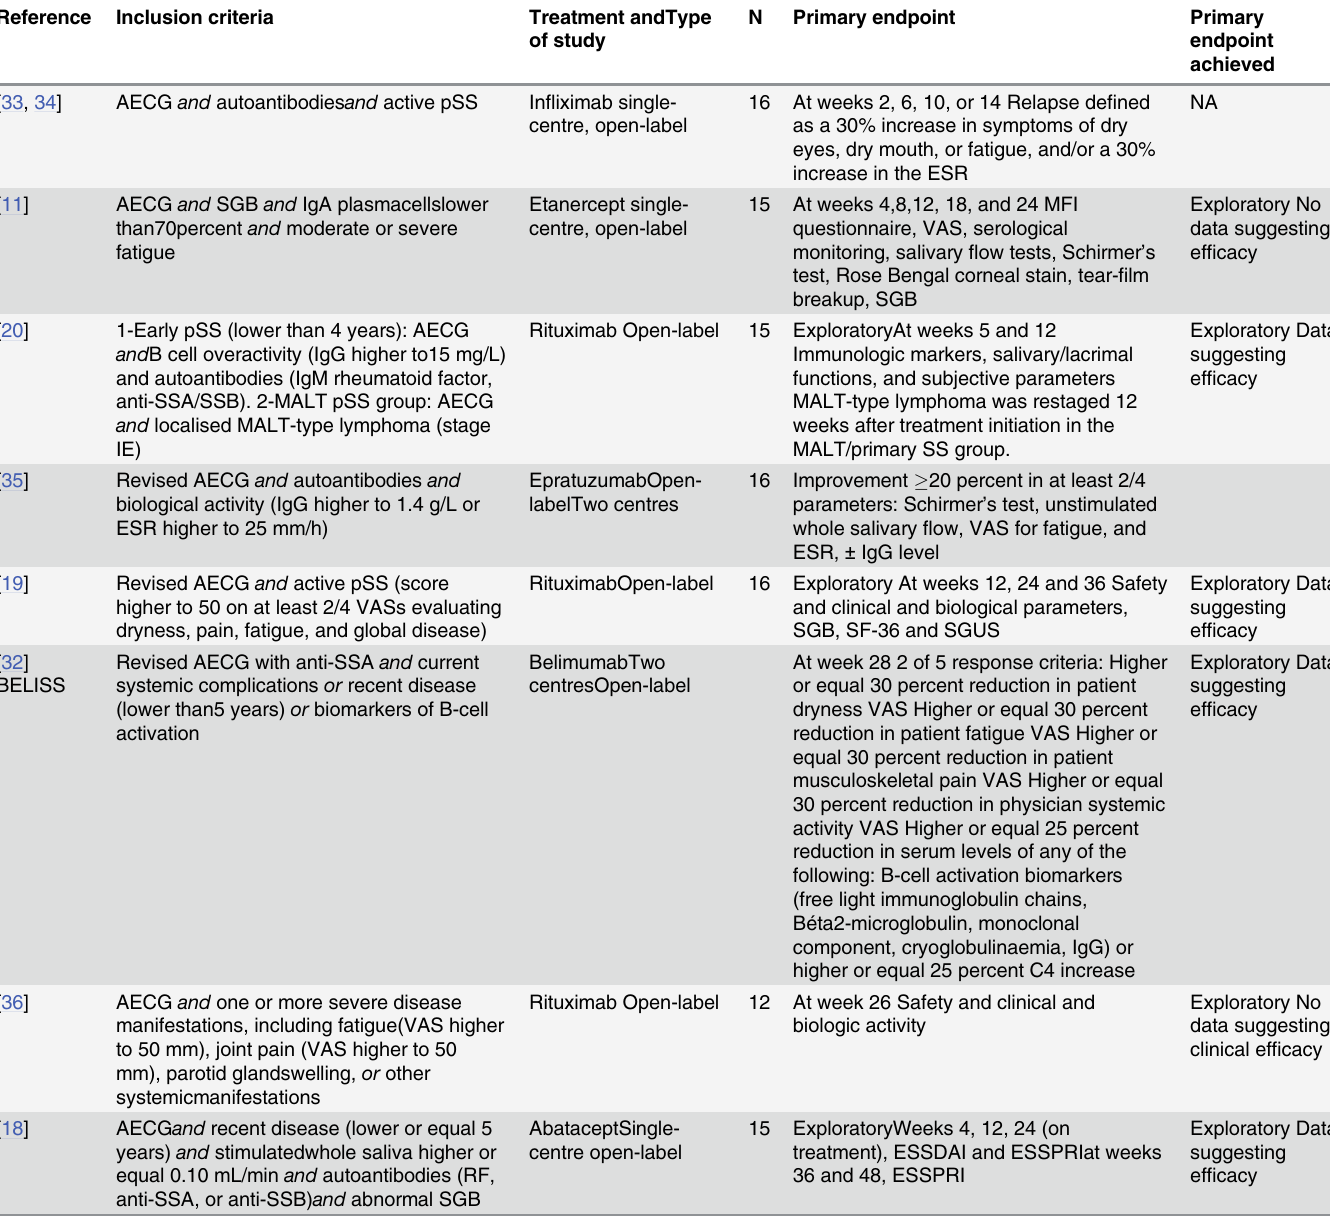
Table 1. Open-label therapeutic trials of biologics in primary Sjögren ’ s disease reported between 2002 and 2014. Reference Inclusion